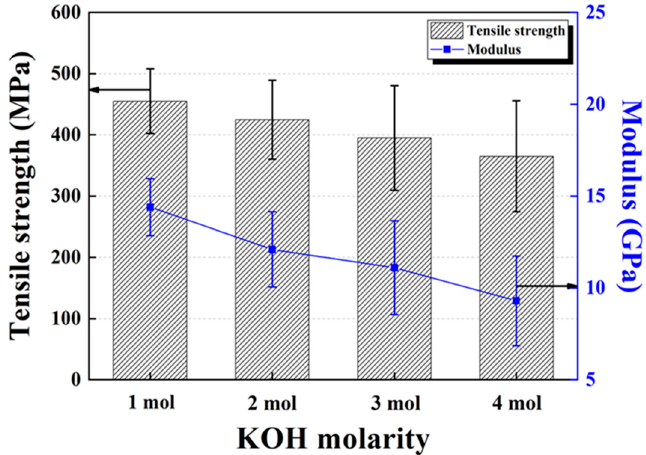
Figure 12. Tensile strength and initial modulus of activated LDPE / HDPE sheath-core carbon fibers at various KOH molarity.